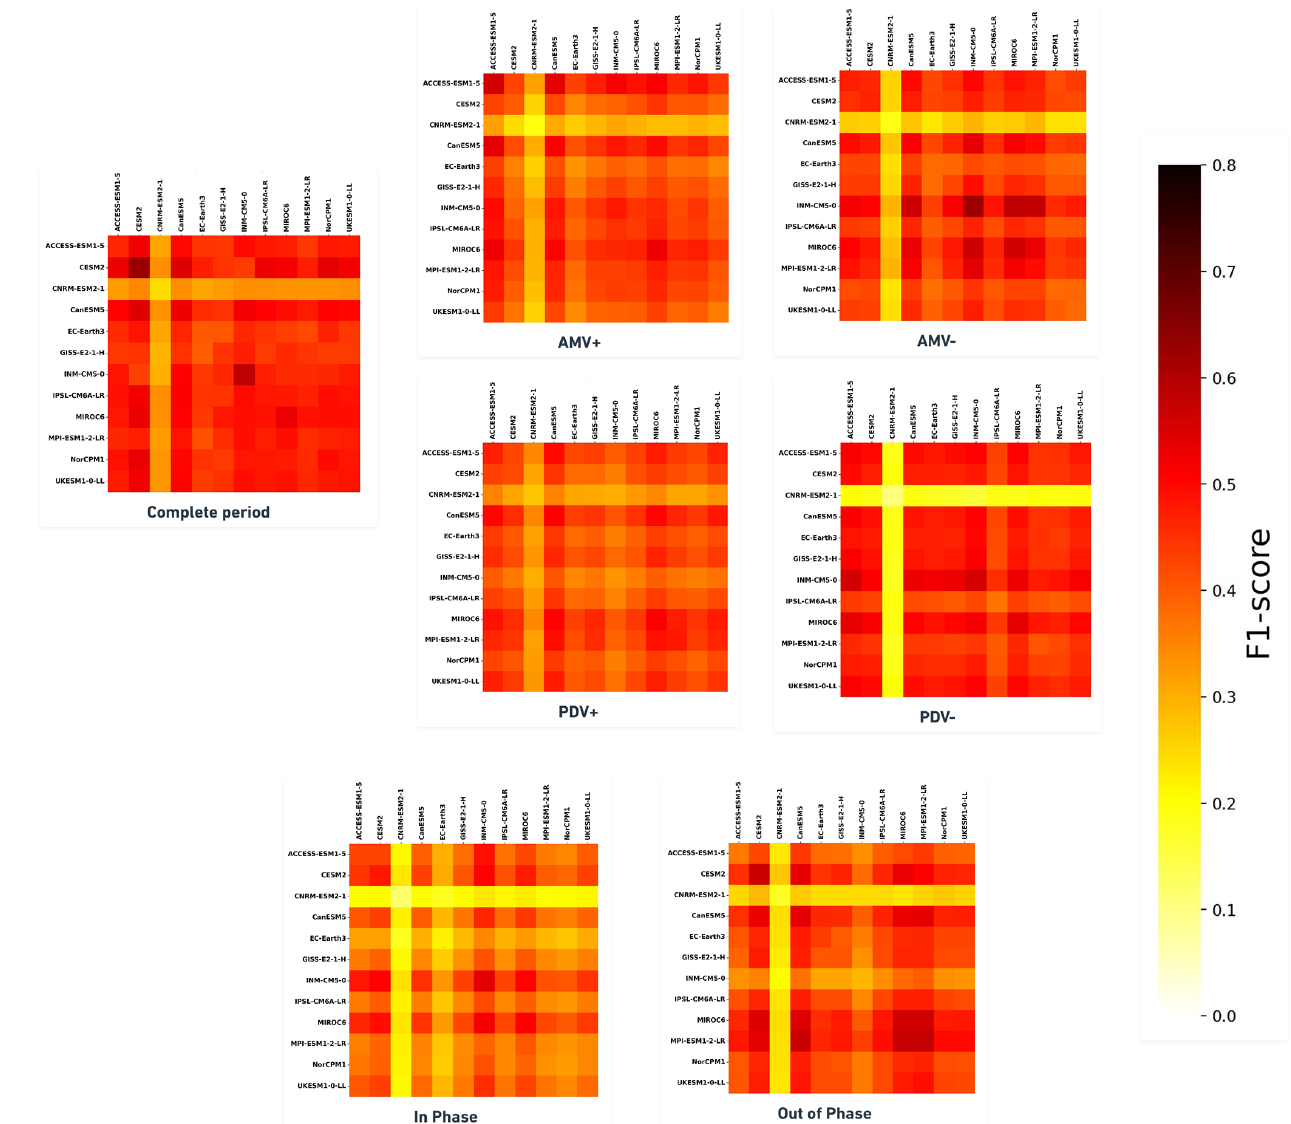
Figure 9. Matrices of average F 1 scores for pairwise network comparisons between ensemble members of 12 CMIP6 LEs during every regime. Boxes on the main diagonal translate the level of similarity between members of a single CMIP6 ensemble. Boxes outside the main diagonal show the similarity between realizations of a CMIP6 LE compared to realizations from another CMIP6 LE (taking every realization as a reference at a time before averaging across every LE). The redder the grid box, the better the causal network similarity it translates when comparing realizations of the corresponding CMIP6 model ( x axis coordinate name on top of each panel) to causal networks from the corresponding reference CMIP6 model ( y axis coordinate on the left of each panel). The matrices for the short regimes (PDV + /AMV + , PDV + /AMV − , PDV − /AMV + and PDV − /AMV − ) are not shown, as their results are not conclusive, since PCMCI + fails to estimate any causal networks for several members of different